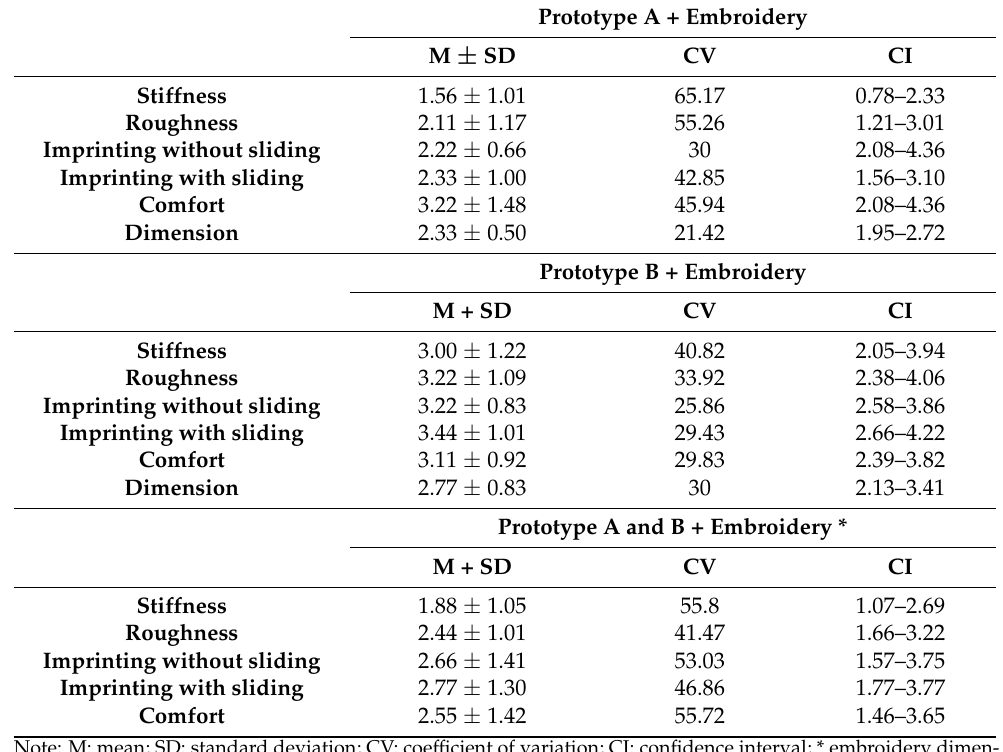
Table 2. Distribution of the mean, standard deviation, and coefficient of variation of the study participants’ evaluation on all items of the sensors of Prototypes A and B and embroidery (n = 9). Coimbra, Portugal, 2022.